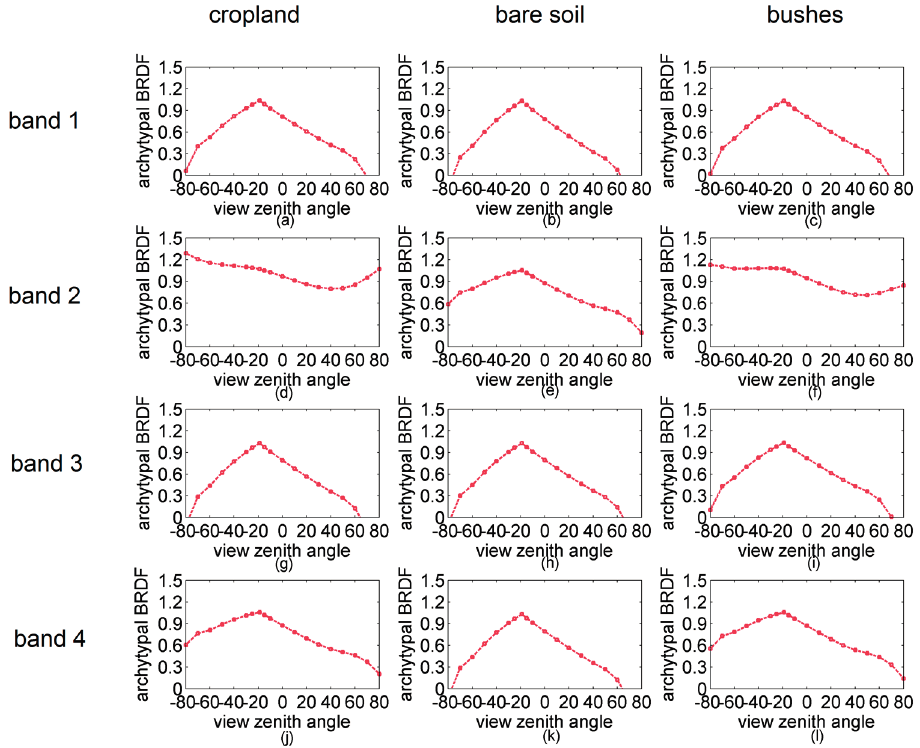
Figure 5. The archetypal BRDF shapes in the principal planes. The three columns from left to right are cropland, bare soil, and bushes; the four rows represent Bands 1–4 ( a – l ). The sun’s zenith angle for all of these planes is 19.01°; positive (negative) view zenith angles refer to forward (backward)